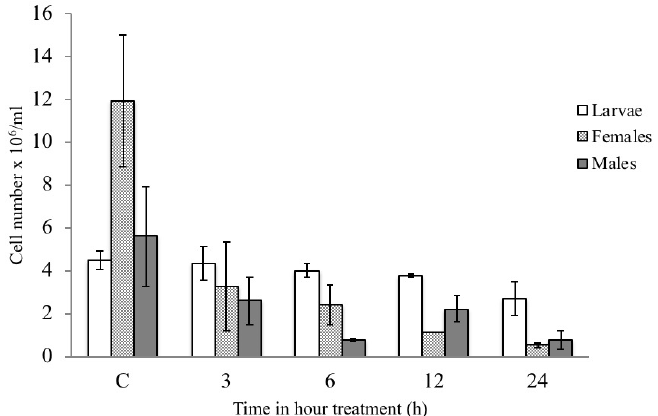
Figure 3. Mean ( n = 10) and standard deviation of total hemocyte count (THC) recorded in the circulating hemolymph from RPW larvae, females, and males fed with untreated diet (control) and with diet containing Bt, collecting 3, 6, 12, and 24 h after treatment. The differential hemocyte count (DHC) from RPW larvae and adults, carried out after Bt treatment, was compared to the controls, as shown in Table 3. Four types of hemocytes were recorded in all instars: plasmatocytes, granulocytes, oenocytes, and prohemocytes. Spherulocytes were recorded in larvae and in males. Three hours after Bt treatment, there was a decrease in all types of hemocyte populations. In particular, granulocytes, oenocytes, and prohemocytes had a statistically significant decrease in females, while plasmatocytes decreased significantly in males. This last type of hemocyte was statistically significant less than the control in larvae after 6 h from the treatment and in females after 12 h. In contrast, a significant increase in the number of oenocytes was recorded in larvae 12 h after Bt treatment. Table 3. Differential hemocytes count (DHC) recorded in the circulating hemolymph from larvae (L), females (F) and males (M) of Rhynchophorus ferrugineus fed with untreated diet (C = 0 h) and with diet containing Bt, collecting 3, 6, 12 and 24 h after treatment. Data are means ± s.d. ( n = 10 control and n = 10 test individuals). Significant differences between the control and treated groups are shown (* p < 0.05; ** p < 0.01; *** p < 0.001). Significant differences among the circulating hemolymph from larvae (L), females (F), and males (M) at the same times are indicated with different